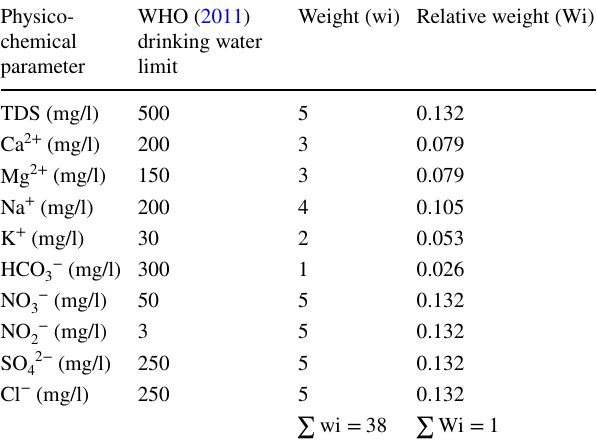
Table 3 WHO standards, assigned weights and relative weights for the calculation of the WQI Physico- chemical